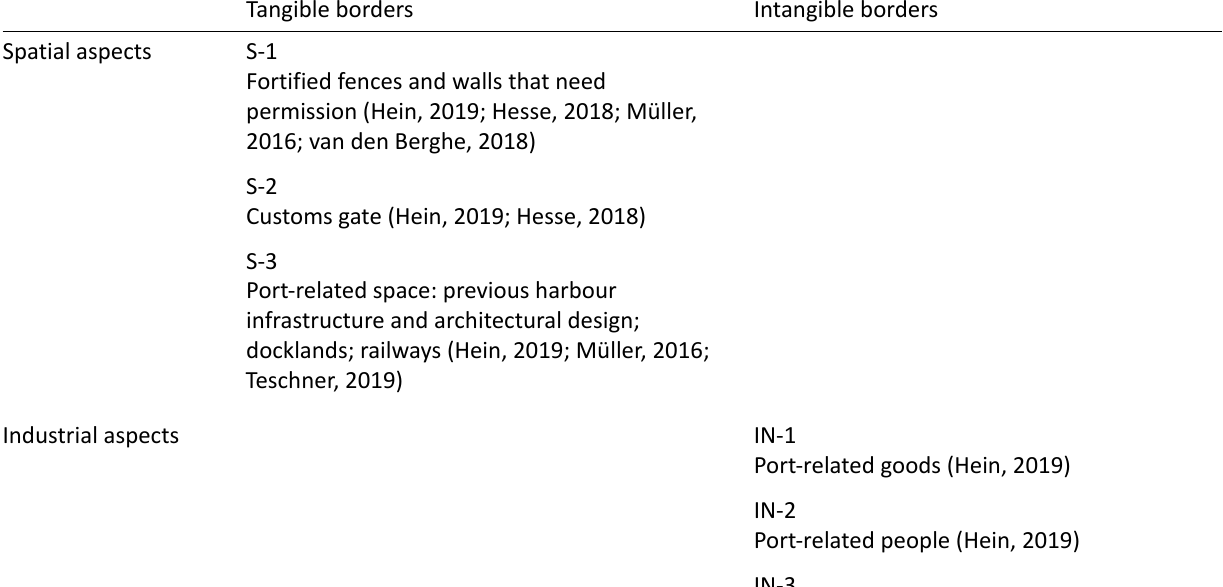
Table 1. Elements related to tangible and intangible boundaries between the port and the